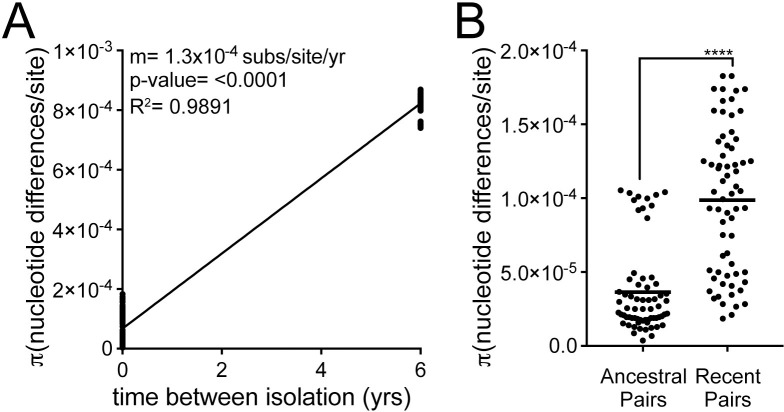
Pairwise comparisons show within host diversification with increasing diversity of infecting populations over time.(A) Plot shows genetic distance for all pairwise comparisons of antral samples isolated within the same time point (n = 132, time between isolation = 0 yrs) and samples isolated from different time points (n = 144, time between isolation = 6 yrs). Each point is a unique pairwise comparison (n = 276). Linear regression with the slope (m) as the estimation of the molecular clock rate, p-value derived from F-test, and correlation coefficient (R2) shown. (B) Each point represents a pairwise comparison between antral isolates within the ancestral population (yr 1994, n = 66) or recent population (yr 2000, n = 66). The average values between all pairwise comparisons in the population (π statistic) is shown with a black bar. Significance was determined using a Student’s t-test (****, p<0.0001).